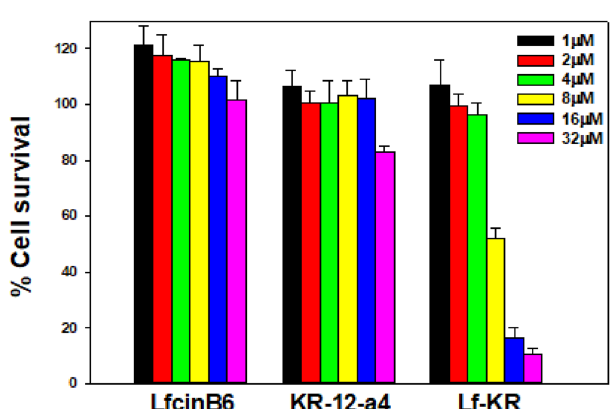
Figure 3. ( a ) Time-dependent cytoplasmic membrane depolarization of Staphylococcus aureus (KCTC 1621) treated with the peptides (2 × MIC) assessed by the release of the membrane potential ‐ sensitive dye, DiSC 3 -5. ( b ) Membrane permeabilization caused by the peptides. Dose-dependent calcein release from EYPE/EYPG (7:3) LUVs induced by LfcinB6, KR-12-a5, and Lf-KR. The fluorescence intensity was measured using an excitation wavelength of 490 nm and an emission wavelength of 520 nm.